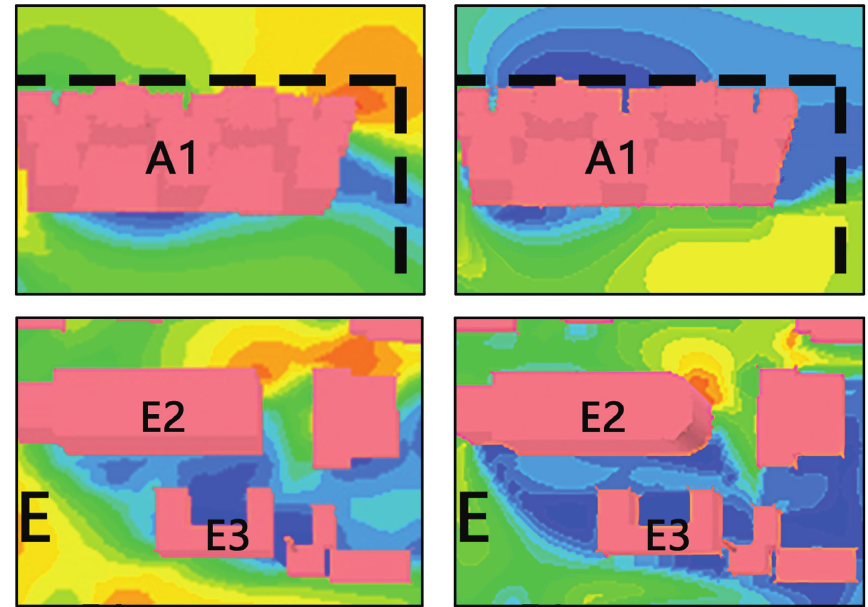
Figure 15: The comparison diagram before and after implementation of optimization.